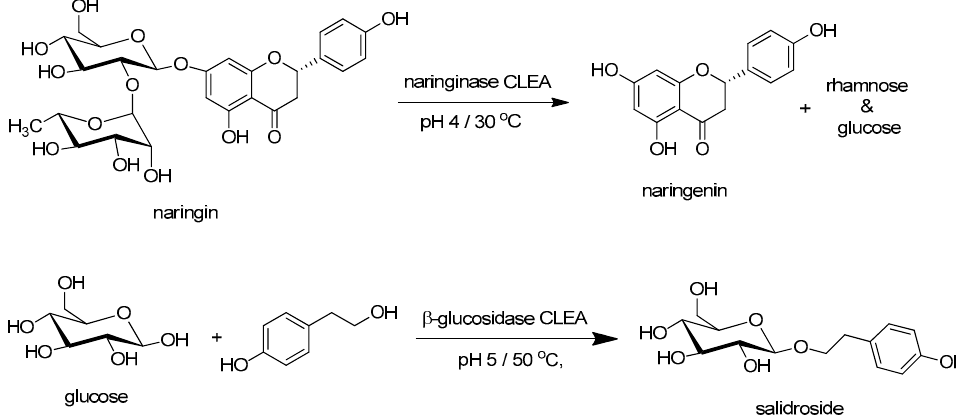
Figure 2. Hydrolysis of naringin and synthesis of salidroside with glycoside CLEAs.